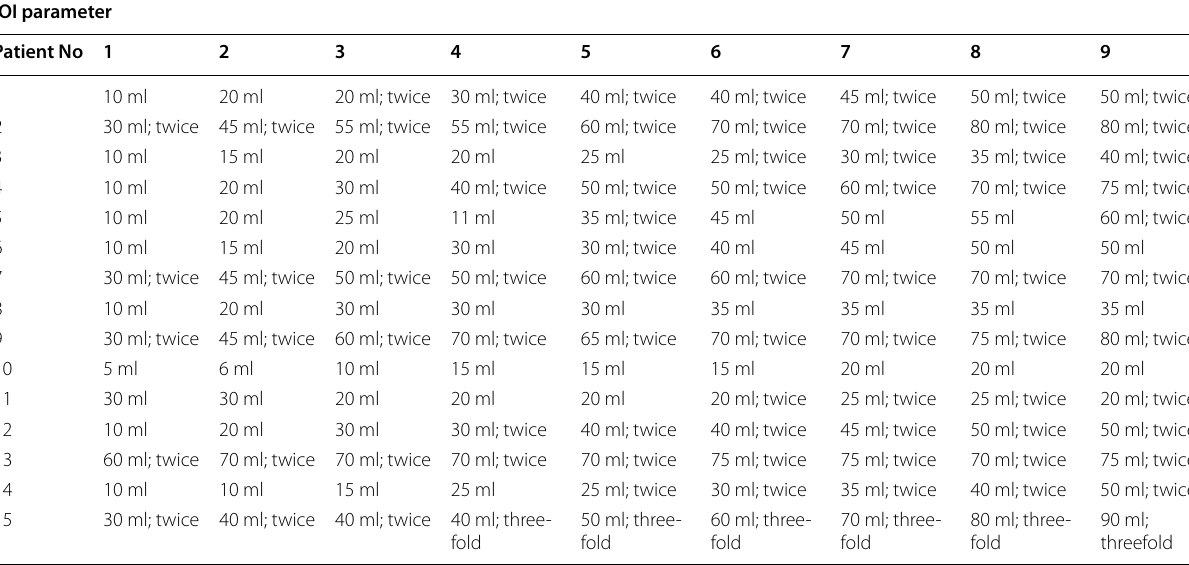
Table 2 Parameter of intravenous oxygen insuffliation (IOI) according to Regelsberger [15] for the 15 patients under study using the the Applimed-O2 1000 IOI parameter Patient No